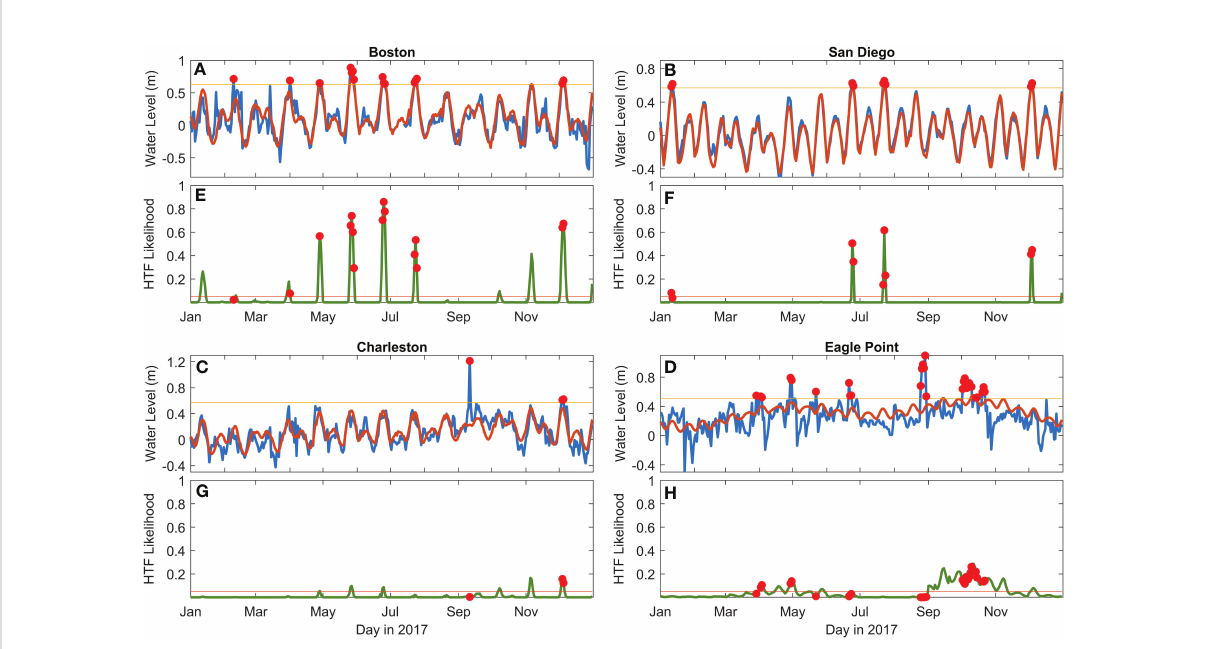
FIGURE 6 Time series examples of daily maximum observed (blue) and predicted (orange) water levels (A – D) and the daily HTF likelihood (green; E – H ) for Boston, MA, Charleston, SC, San Diego, CA, and Eagle Point, TX for 2017. Red dots show days when HTF occurred and the horizontal yellow line shows the minor fl ood threshold (A – D) and 5% warning threshold (E – H)